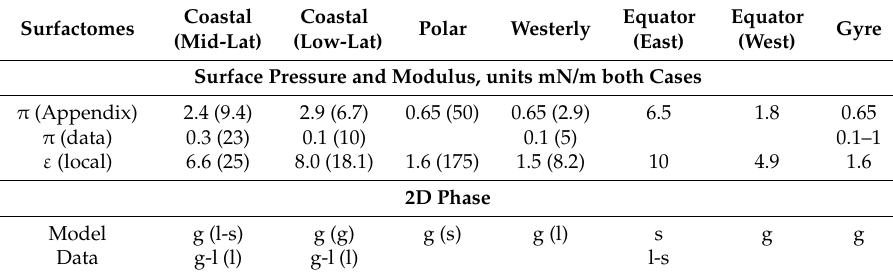
Table 4. Upper lines—surface pressure estimates based on collected results from Table 3 and computed per the Appendix A, with a selection of data spanning several decades for comparison. In the center of the table, local elastic modulus results are offered. Finally, in the lower lines, model and data π -A experiments are reported in the form of phases. The background (bloom) nonparenthetical (parenthetical) convention is retained. Letters g, l and s stand for 2D gas, liquid and